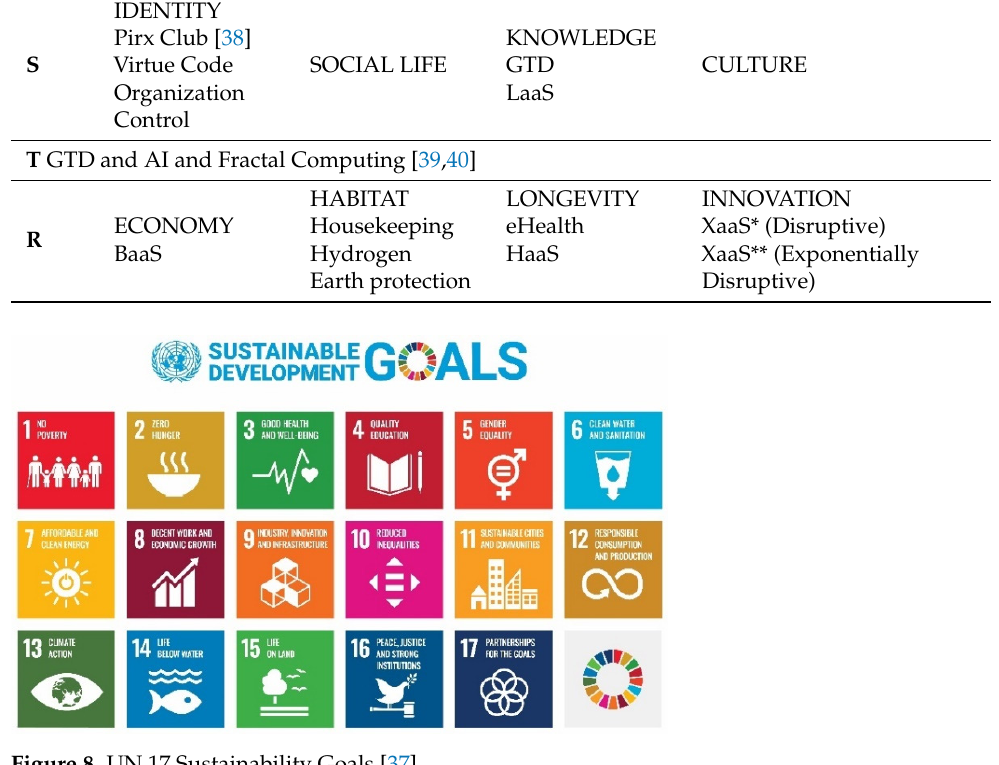
Figure 8. UN 17 Sustainability Goals [37]. Table 2. Illustrating the ReSeT model in the context of the wellness domain.